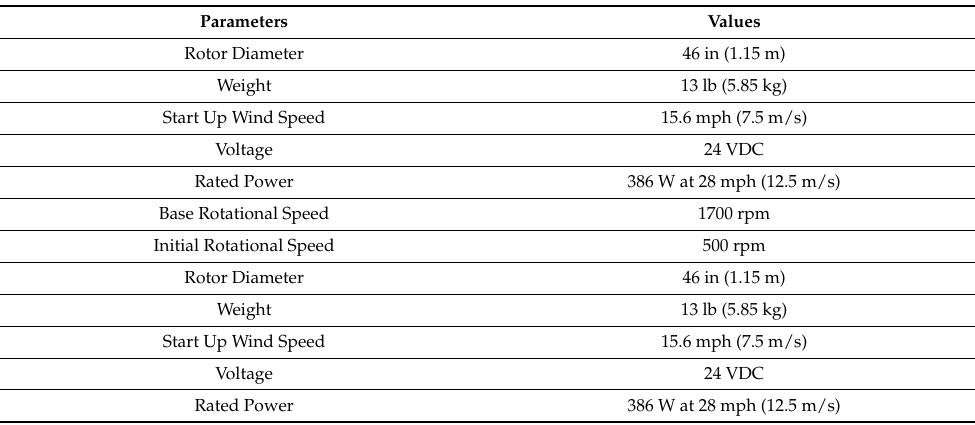
Table 2. Main parameters of the